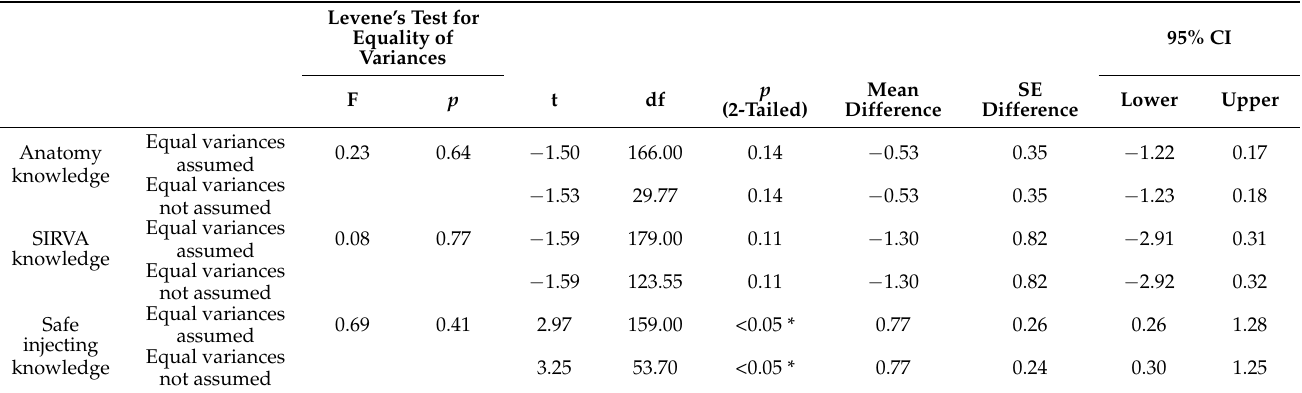
Table A5. Independent T-Test comparing high and low self-declared